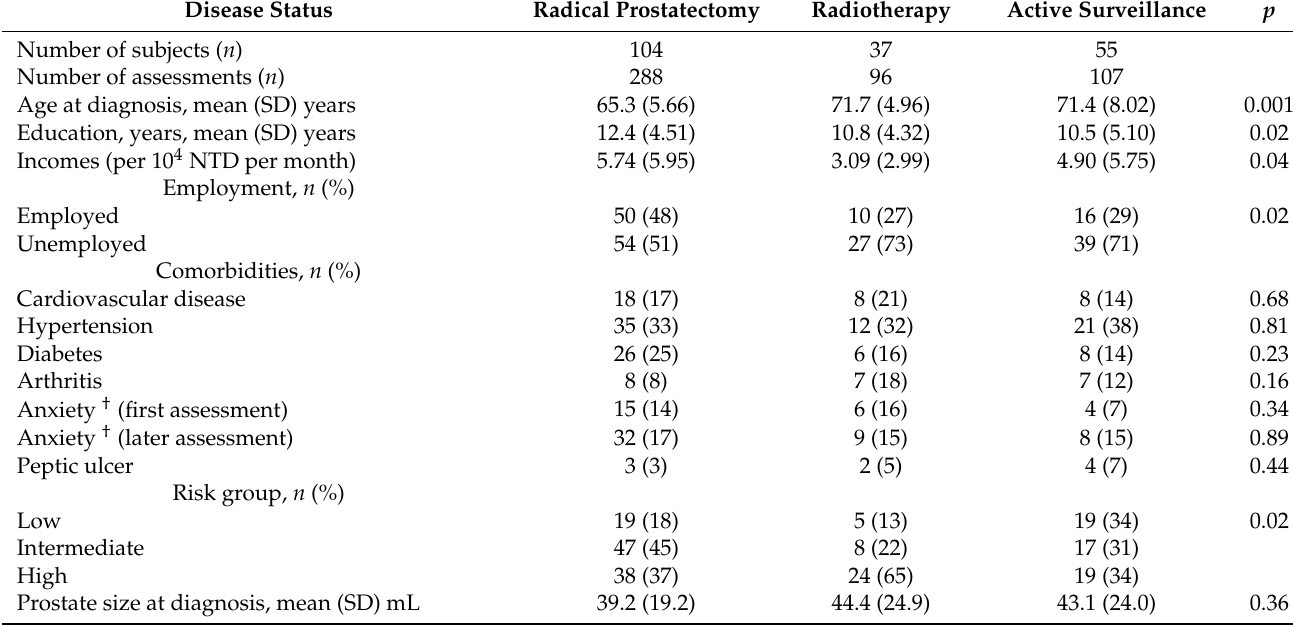
Table 1. Baseline demographic and clinical characteristics among participants stratified by